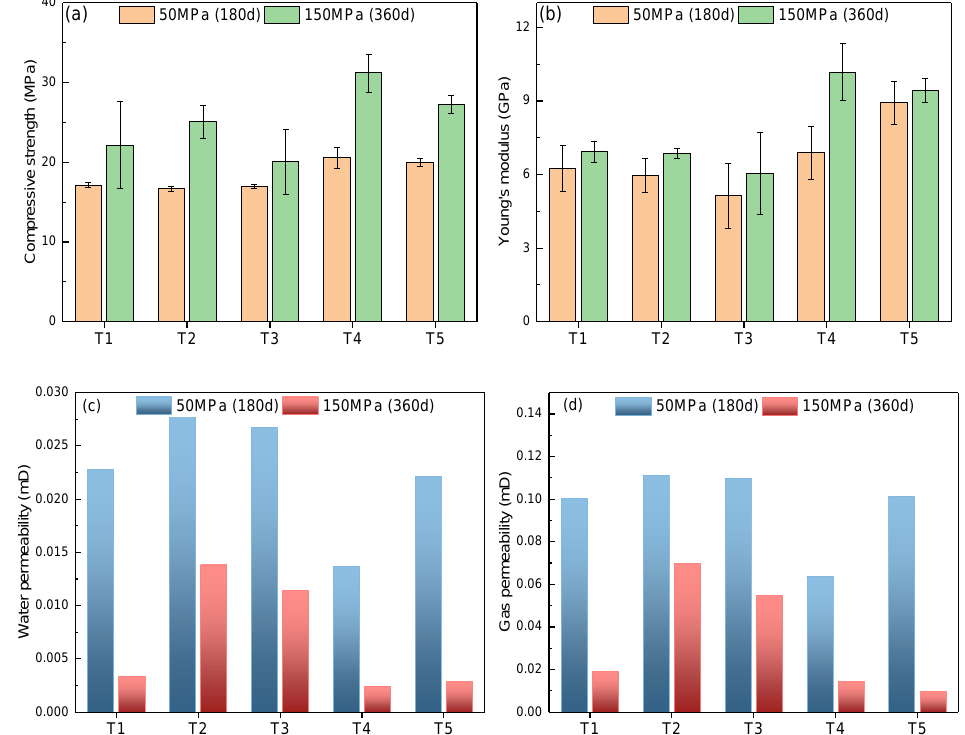
Figure 9. Mechanical properties and permeability of slurries T1 to T5 showed possible significant influence of curing pressure on the long-term test results: ( a ) compressive strength; ( b ) Young’s modulus; ( c ) water permeability; ( d ) gas permeability. (Note: it is expected that the 360 d test results at 50 MPa would be worse than 180 d according to the trend shown in Figure 2) (T1: low α -Al 2 O 3 content, T2: no nano-Fe 2 O 3 , T3: control; T4: latex fiber, T5: nano-graphene).